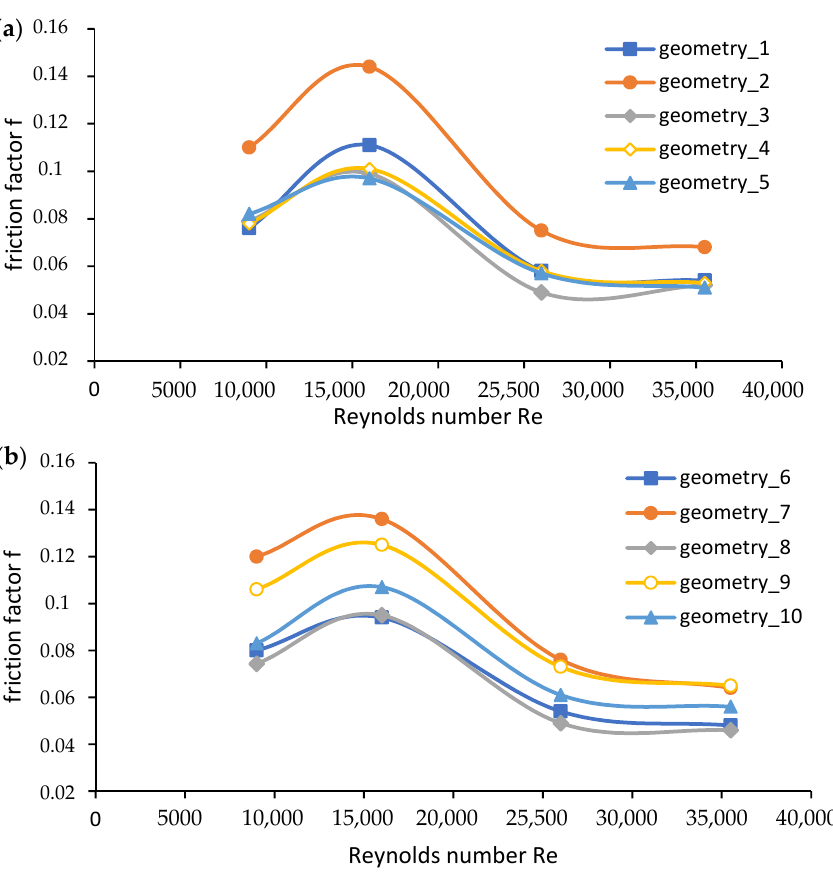
Figure 24. The Darcy–Weisbach friction factor f plotted against Reynolds number for different configuration and P/e = 11 ( a ) and P/e = 6.6 ( b ).